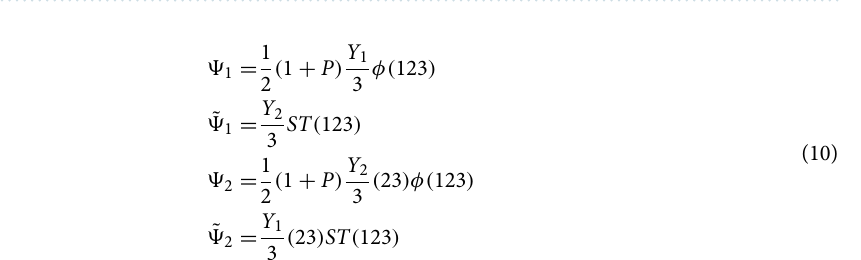
3 He, using the one-photon approximation and neglecting neutron